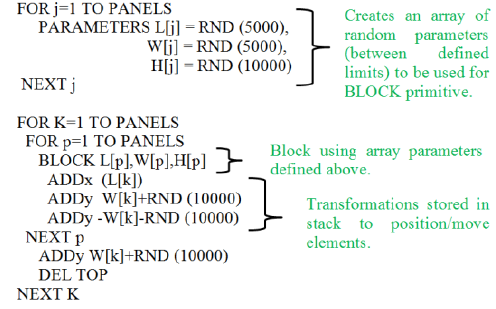
Figure 9. GDL code which randomly generates 3D content shown in Figure 10.